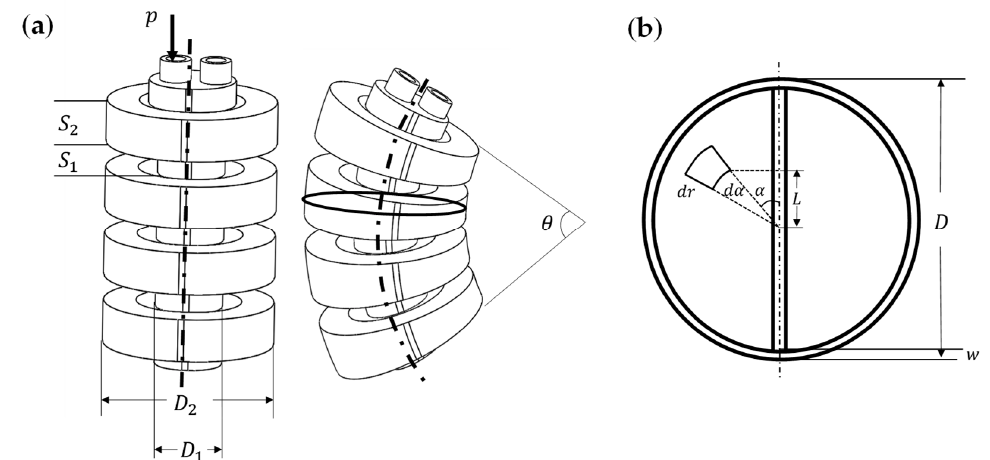
θ when left cavity’s air